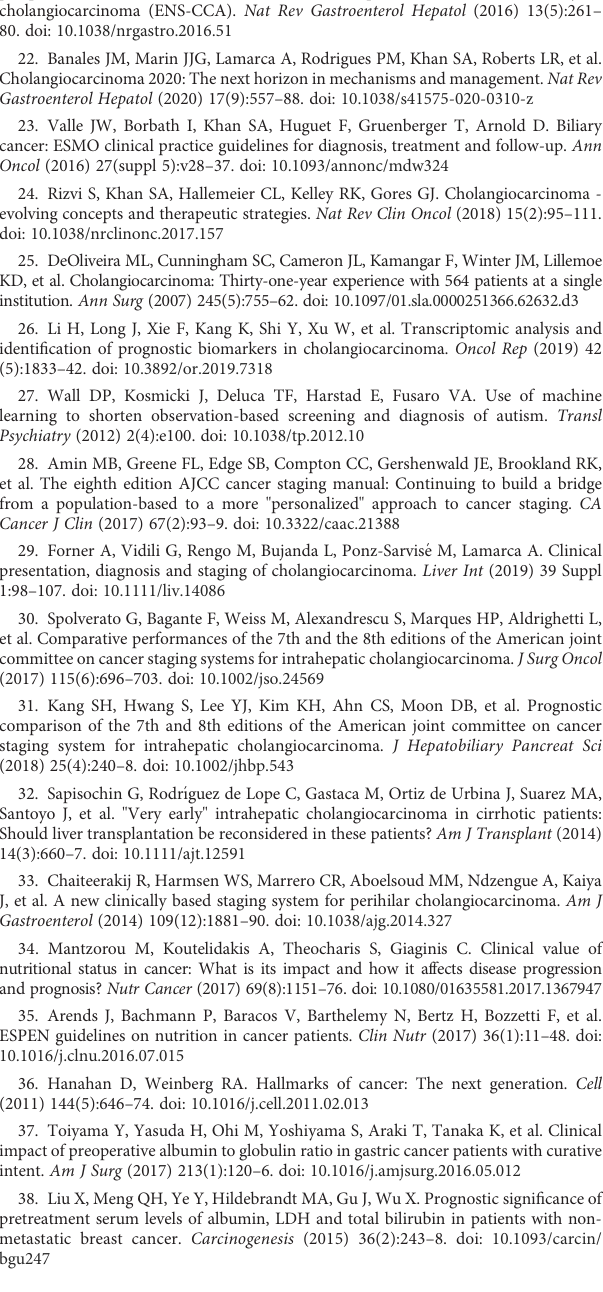
SUPPLEMENTARY FIGURE 2 Cumulative incidence curves of the training cohort and the validation cohort. Cumulative incidence curve in the training cohort and the validation cohort. There was no statistically signi fi cant difference between the survival of the two cohorts using the log-rank test (p = 0.21). SUPPLEMENTARY FIGURE 3 The Kaplan – Meier analysis and log-rank test in different AFR groups. The Kaplan – MeieranalysisindifferentAFRgroups.Therewasastatisticallysigni fi cantdifference between the survival of the two groups using the log-rank test (p = 0.0013).